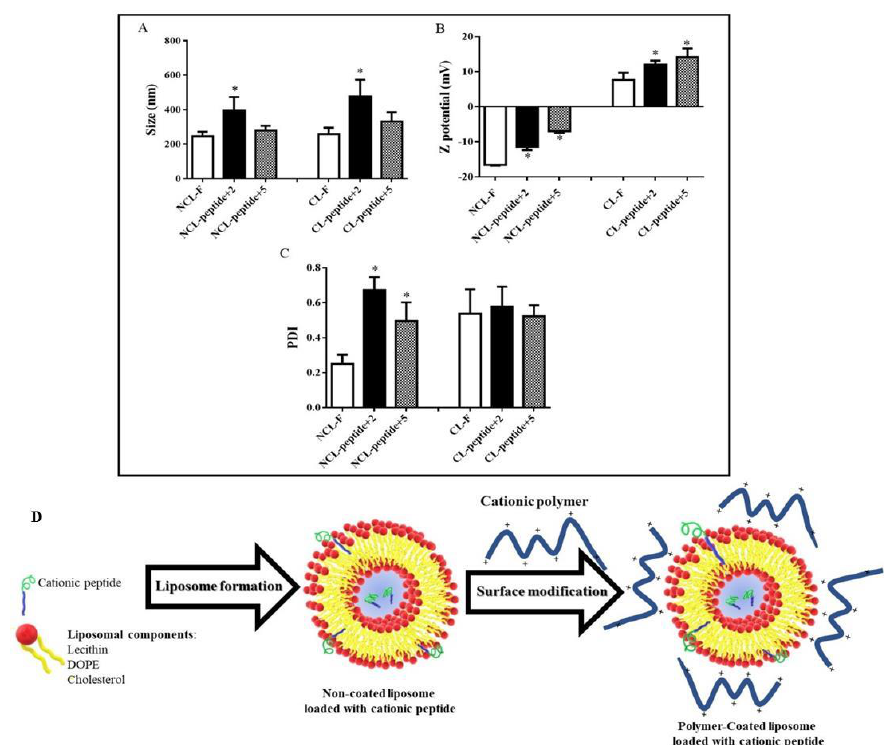
Figure 5. Mean values of ( A ) particle size, ( B ) Z-potential, ( C ) polydispersity index (PDI) and ( D ) scheme formation of liposomes loaded with cationic peptides +2 and +5 before (NCL) and after (CL) the coating process. Data are the average of at least three independent experiments ± s.d. Error bars represents the standard deviation. * Significant difference p < 0.05 to the NCL and CL without peptide (NCL-F and CL-F, respectively).